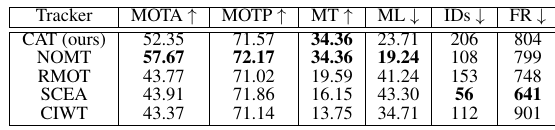
Table 3. Evaluation results on the Kitti data set of our tracking method CAT and other state-of-the-art methods. with many